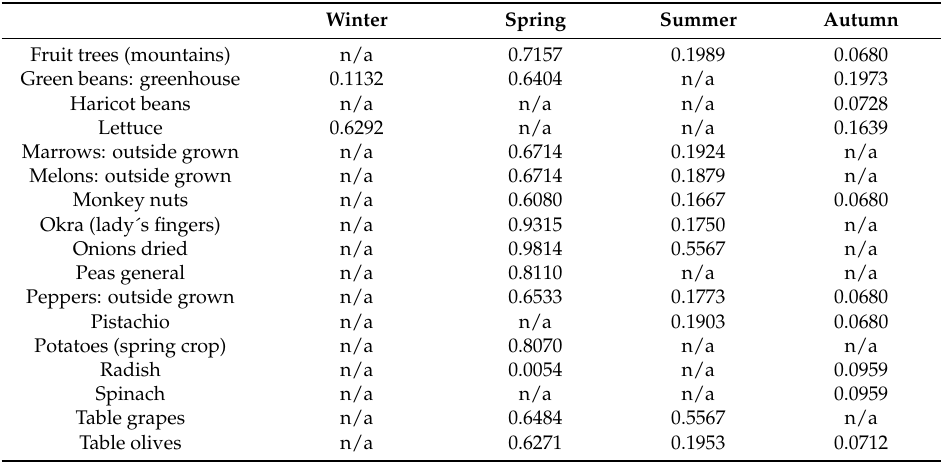
Table 1. p -Values for the comparison of seasonal net irrigation requirements (NIR) between the two periods (1976–2000 and 1990–2014) for selected crops cultivated in Cyprus. Months that are not included in the irrigation period of a crop are indicated by n/a